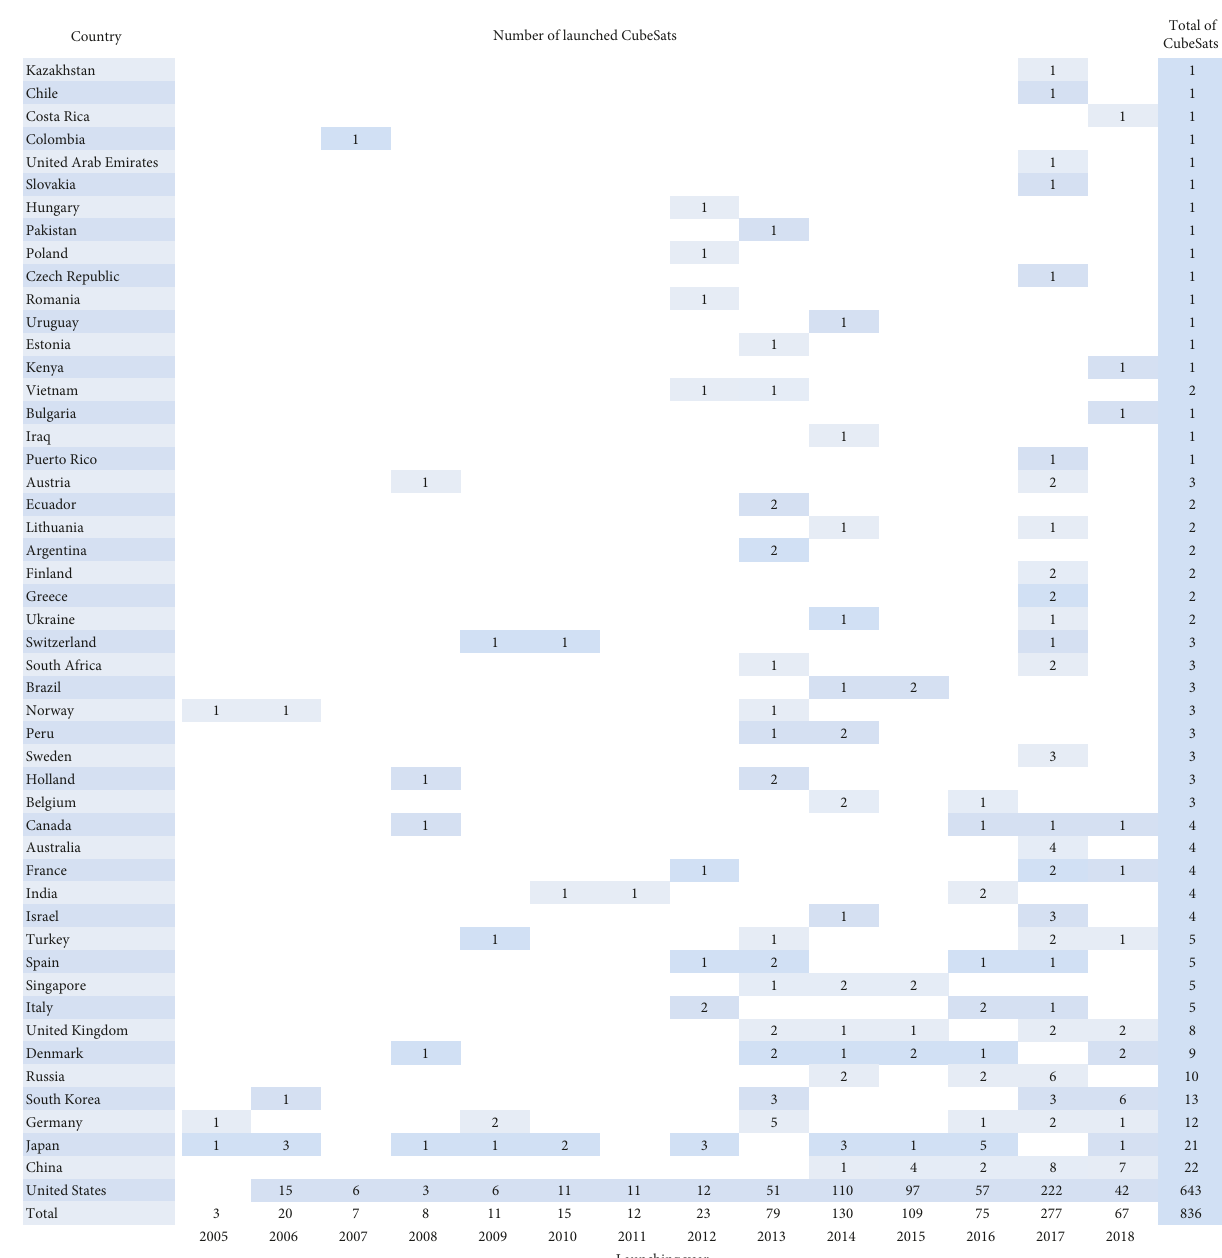
Figure 2: Number of CubeSats launched per year per country from 2005 to May 31,